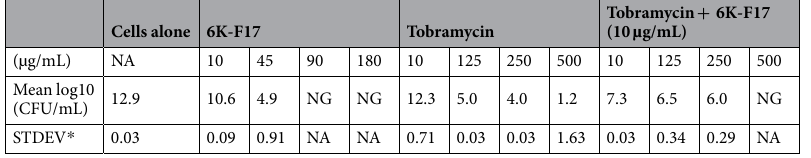
Table 2. Colony forming units per mL (CFU/mL) of P . aeruginosa PAO1 exposed to various concentrations of peptide 6K-F17, tobramycin, or a combination of tobramycin and 6K-F17. NA: Non-applicable; NG: No growth; STDEV: Standard deviation. The mean of n = 2 biological replicates is shown. * Standard deviation calculated on log transformed CFU/ml data of biological replicates.